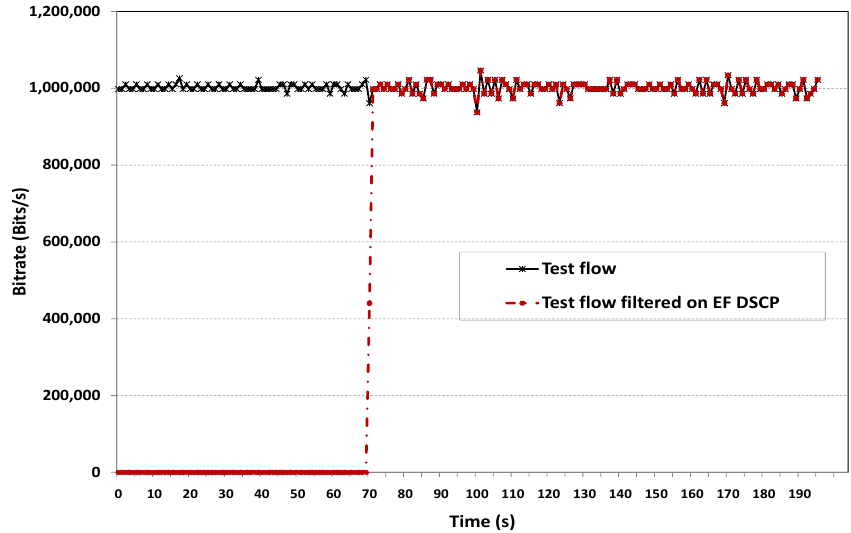
Figure 5. Effect of adaptive policy QoS reconfiguration on test flow with increasing background traffic